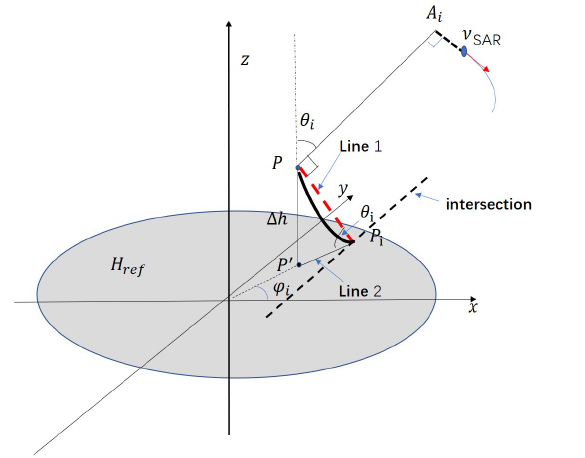
Figure 2. Imaging geometry of one certain aspect angle. A target is above the imaging